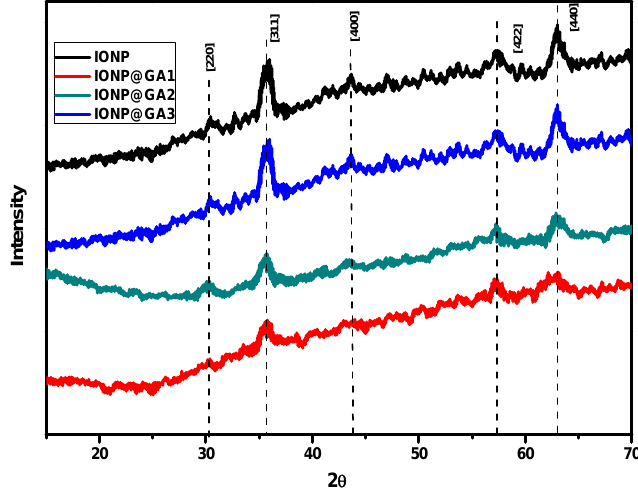
Figure 3. XRD spectra of unfunctionalized and functionalized